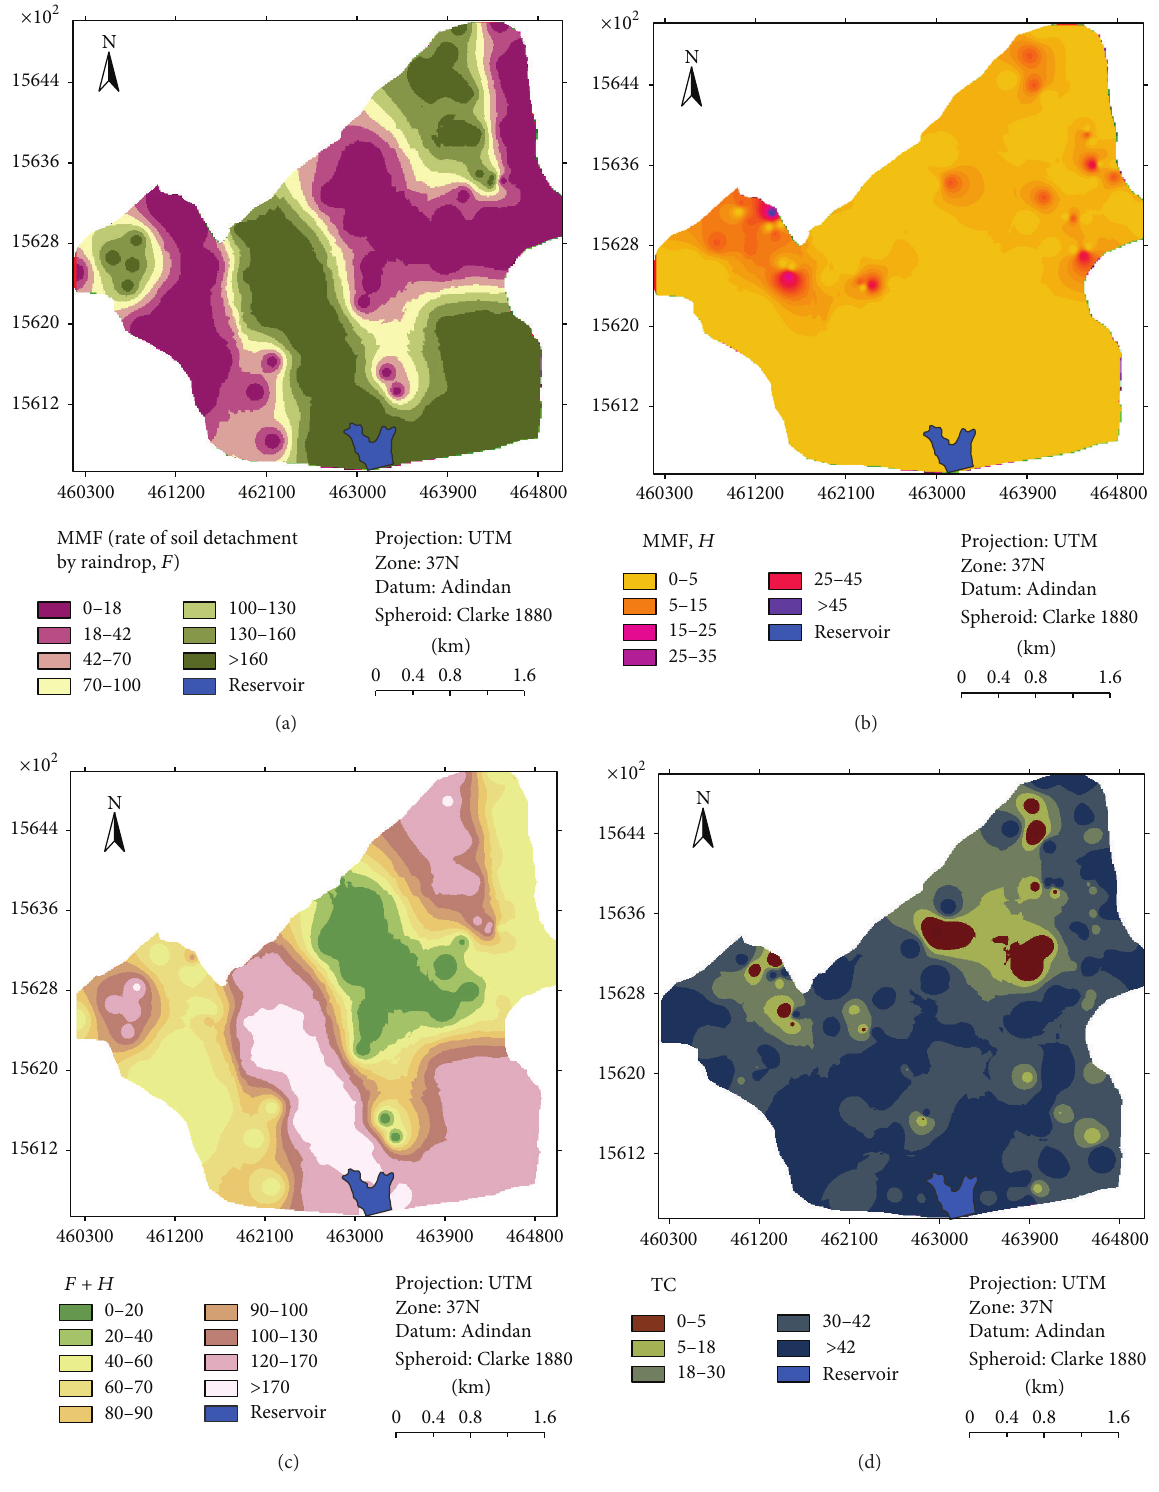
Figure 6: Spatial distribution of MMF erosion estimation. (a) Rate of soil detachment by rain drop impact ( 𝐹 ) (tha −1 y −1 ); (b) rate of soil detachment by runoff impact ( 𝐻 ) (tha −1 y −1 ); (c) total soil detachment ( 𝐹 + 𝐻 ) (tha −1 y −1 ); and (d) soil transport capacity of overland flow (TC) (tha −1 y −1